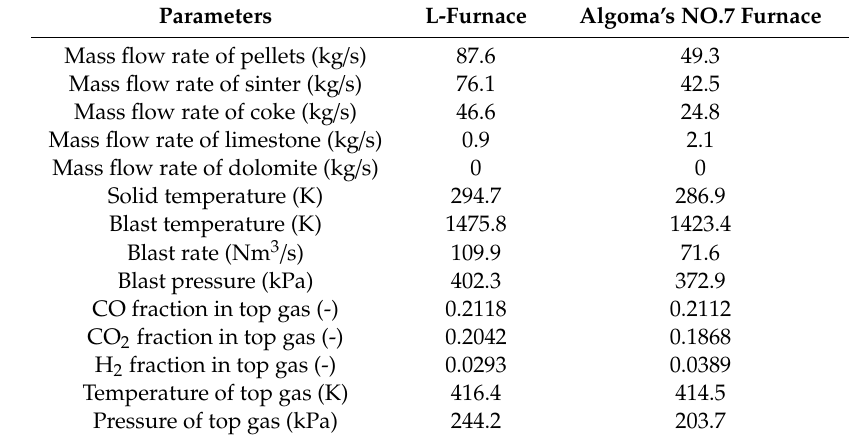
Table 3. Operating parameters of two reference BFs.